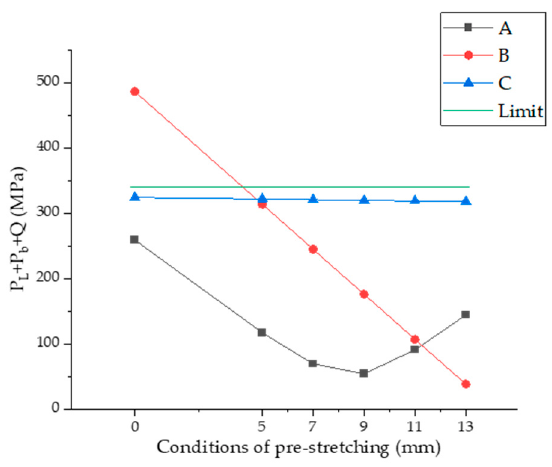
Figure 12. P L + P b + Q assessment at positions A, B and C under load case 2 with varying preten-